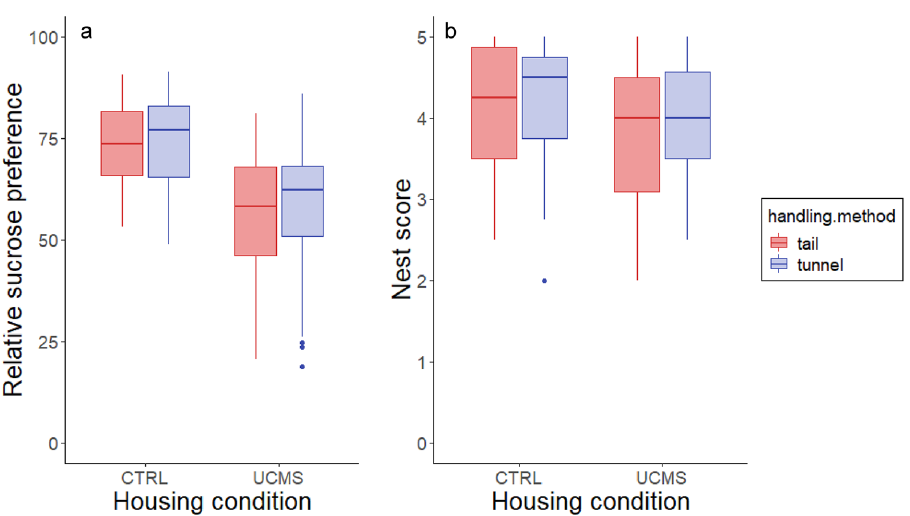
Figure 6. ( a ) Relative sucrose preference was lower in UCMS mice. Handling method had no effect on relative sucrose preference. ( b ) Nest scores did not differ between UCMS and CTRL mice nor between tail and tunnel handled